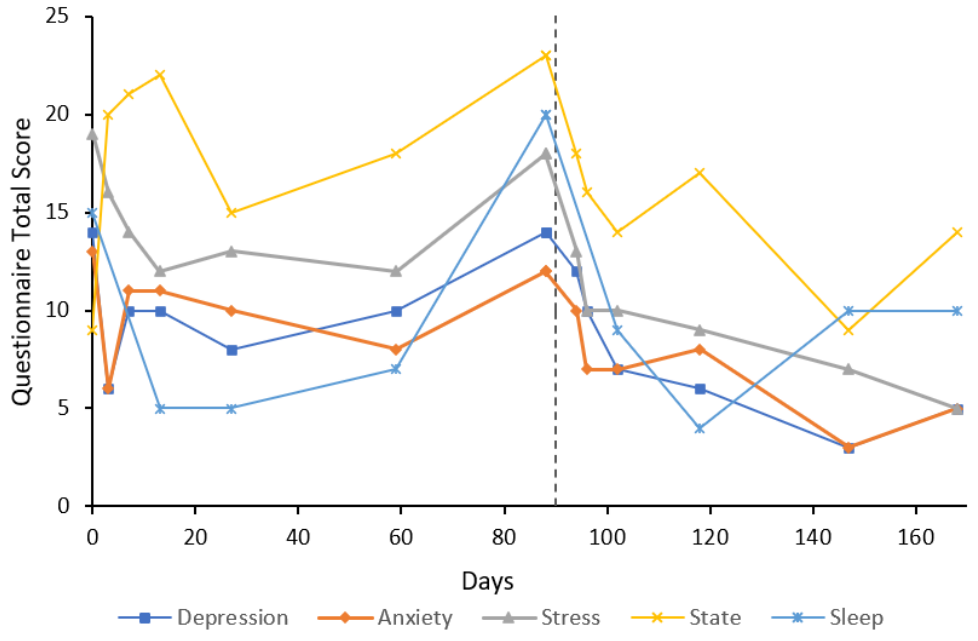
Figure 6. Line graph showing Case 6 results from the DASS-21 (depression, anxiety, and stress subscales), SSAI-6, and JSS at each follow-up. The participant was treated with an eight-day flumazenil infusion and re-treated on day 90 with an eight-day flumazenil infusion (denoted by a dashed line). Case 7 was a 31-year-old male with a 20-year history of GAD and comorbid MDD. The participant had previously taken mirtazapine for MDD, which was not given an adequate trial as it did not “agree with [him] at all”. Accordingly, the participant was reluctant to try other antidepressant therapies. At baseline, anxiety and stress subscale scores were severe (9) and moderate (12), respectively. The depression subscale score in this participant was considerably higher than the other participants at 19, which is only two points lower than the maximum score. U&E, FBC, and TFT were unremarkable at baseline. Bilirubin (25 µ M/L), AST (47 U/L), and ALT (68 U/L) were elevated. The participant day four of flumazenil treatment, bilirubin (24 µ M/L), AST (41 U/L), and ALT (59 U/L)